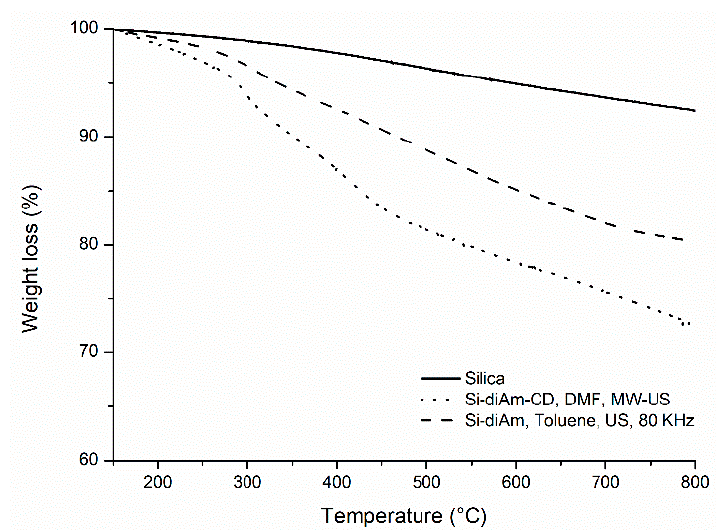
Figure 7. TGA profile of Si-DiAm-CD. (Solid line) Starting silica; (dashed line) Si-DiAm, obtained in US at 80 kHz, 2 h, toluene, Table 3, Entry 4; (dotted line) Si-DiAm-CD, MW-US combined irradiation at 100 °C, 4 h, DMF, Table 3, Entry 9. Table 3. Synthesis of Si-diAm-CD.